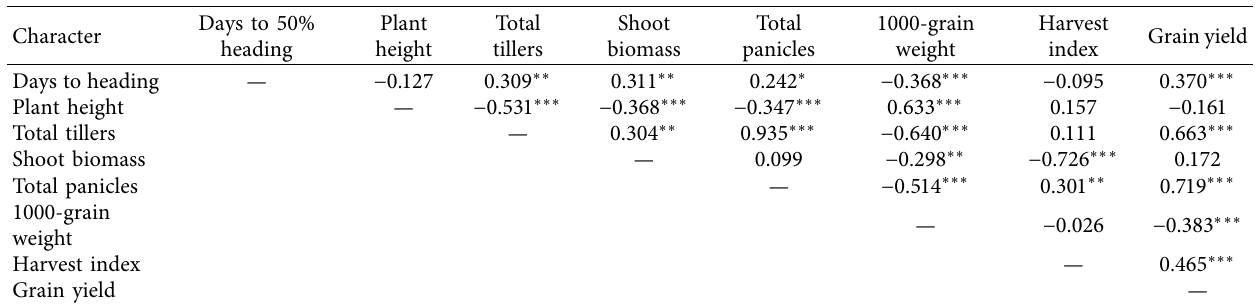
∗∗∗ and ∗∗ refer significant difference at P < 0 . 001 and P < 0 .